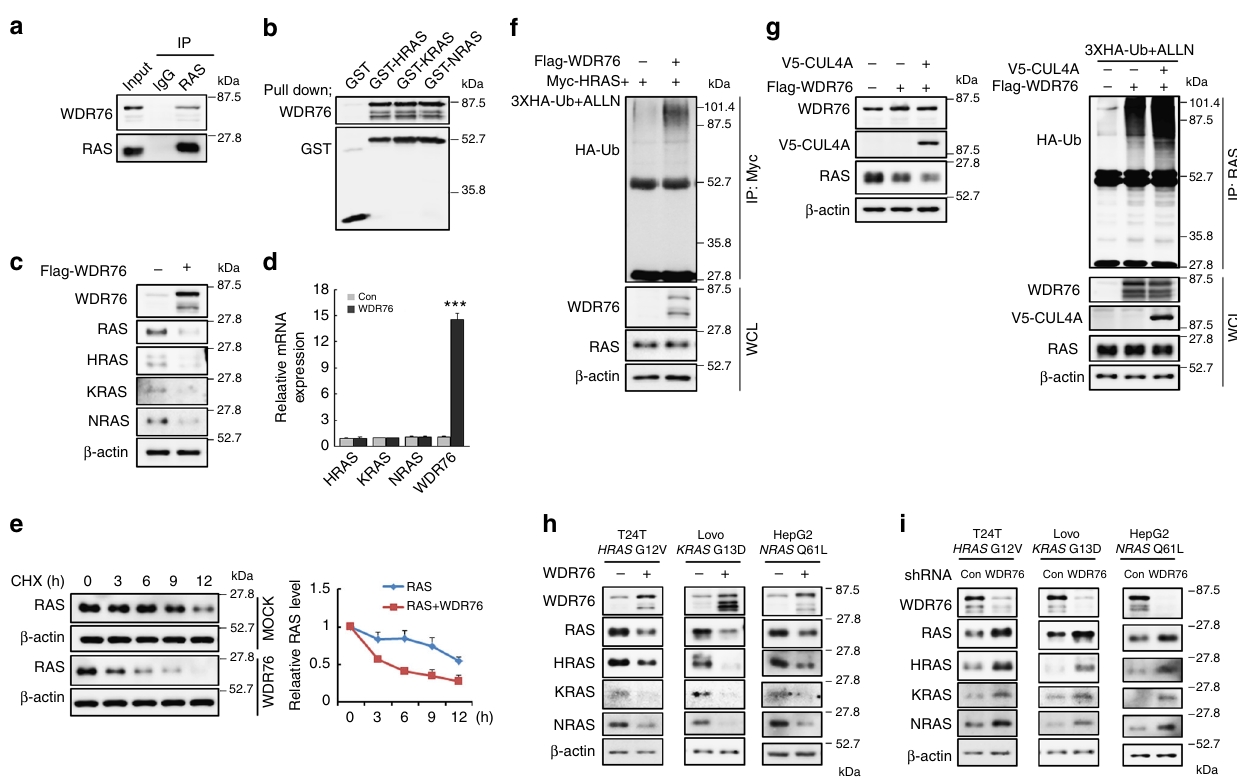
Fig. 2 WDR76 interacts with RAS and mediates their ubiquitination-dependent proteasomal degradation. a Interaction of endogenous RAS with WDR76 determined by immunoprecipitation in HEK293 cells. b HEK293 WCLs were pulled-down with recombinant GST-H, -K, or -NRAS protein. c – e HEK293 cells were transfected with Flag-WDR76 expression vector. WCLs were subjected to IB to detect indicated proteins ( c ). The mRNA levels of H, K, NRAS , and WDR76 were measured by quantitative RT-PCR; geometric mean of GAPDH , β -actin , and HPRT was used as an internal control. Data are presented as the mean ± SD ( n = 3 biological replicates). Statistical signi fi cances were assessed using two-sided Student ’ s t test, *** p < 0.001 ( d ). The levels of RAS at indicated time points after CHX treatment were determined by IB, and were quanti fi ed with β -actin as a loading control. Results plotted on the the right are the amounts of RAS at each time point relative to the level at time 0. Data are presented as the mean ± SD ( n = 3 biological replicates) ( e ). f HEK293 cells were transfected with indicated vectors and then treated with ALLN. WCLs were then immunoprecipitated with an anti-Myc antibody. g HEK293 cells were transfected with Flag-WDR76 or V5-CUL4A together with 3XHA-Ub construct then treated with ALLN (left panel). WCLs were immunoprecipitated with anti-RAS antibody. h , i T24T, Lovo, or HepG2 cells were transfected with WDR76 ( h ) or shWDR76 ( i